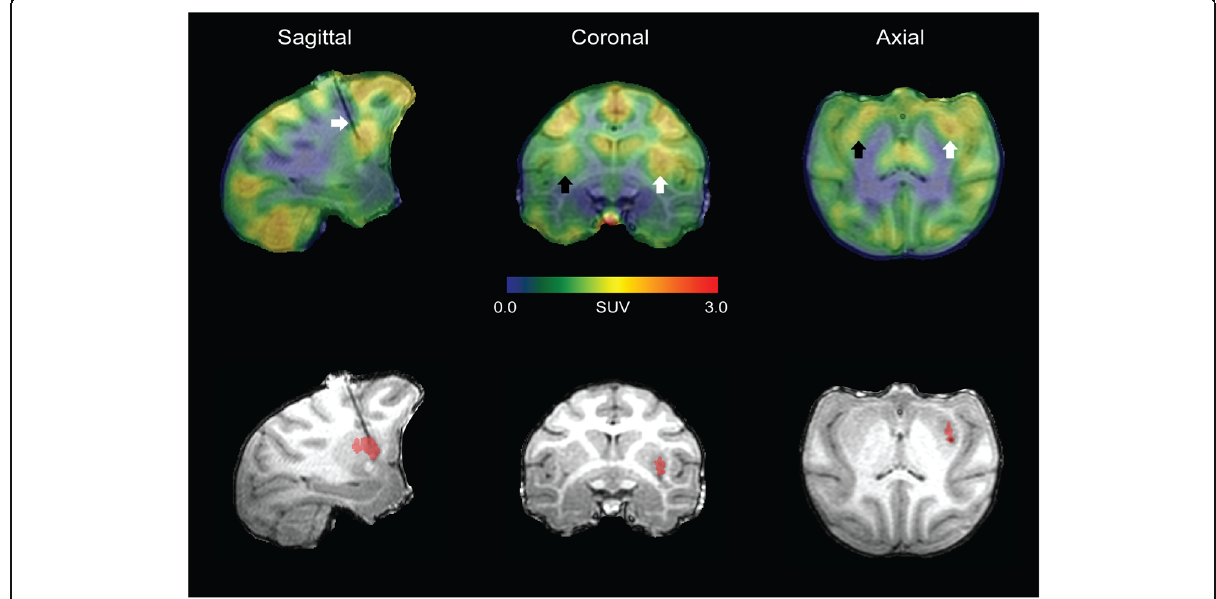
Fig. 2 Representative [ 18 F]FEPPA PET brain image of a rhesus macaque (R1) with allogeneic iPSC-mDA. Visual asymmetry in uptake is detected in the putamen of monkeys with allogeneic grafts. Images were overlayed on the MRI acquired during RT-IMRI delivery of the iPSC-mDA. Arrow in sagittal slice points to the cannula used for cell delivery. Arrows in coronal/axial slice point to the contralateral (left, black arrow) and ipsilateral (right, white arrow) putamen. The red overlay in the MRI is representative of the allogeneic iPSC-mDA graft and was utilized for visualization